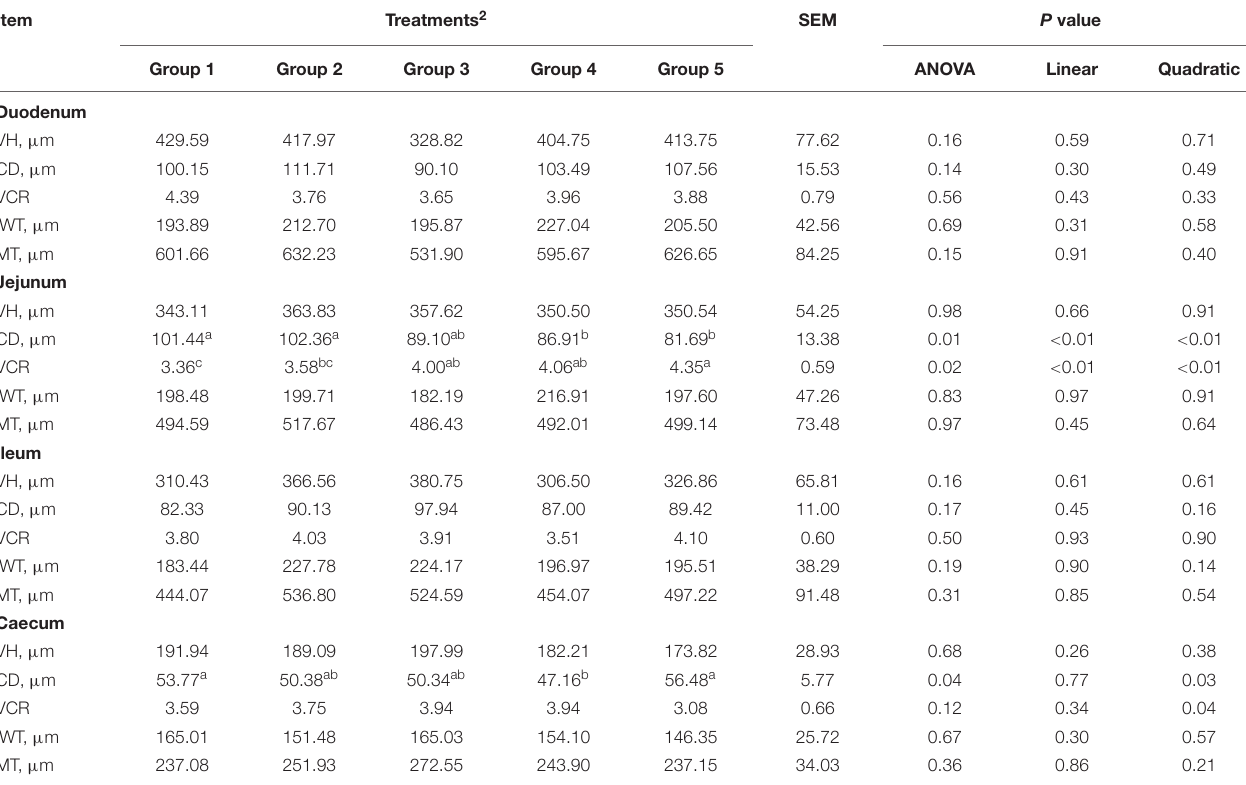
TABLE 5 | Effect of different dietary FA supplementation on intestinal morphology of experimental ducks 1 . Item